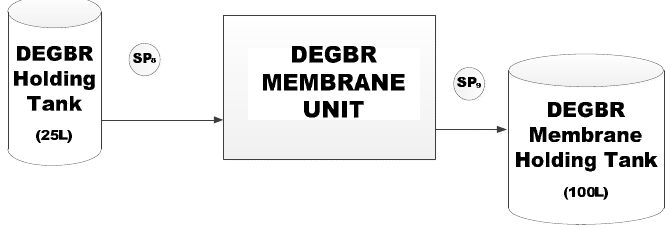
Figure 5. Membrane Bioreactor Unit Set-up. (SP=sample point).